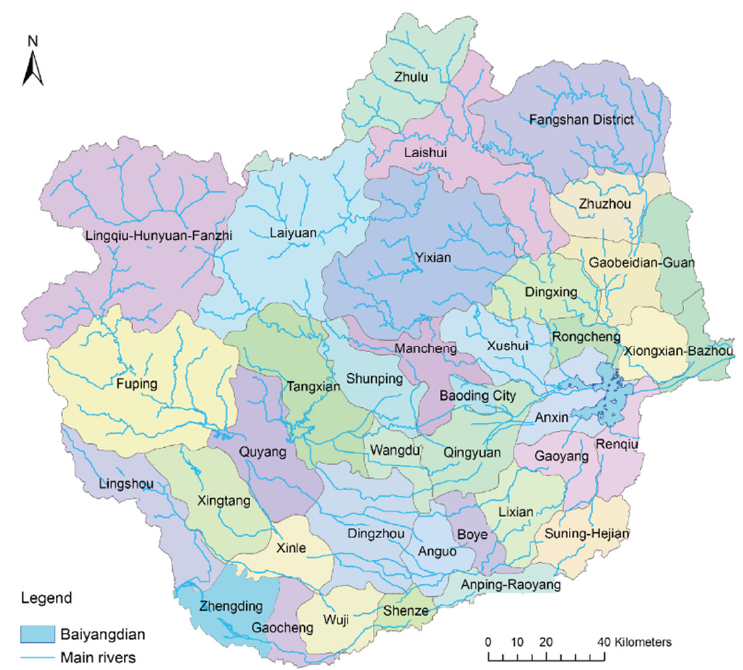
Figure 1. The research area of Baiyangdian lake basin.